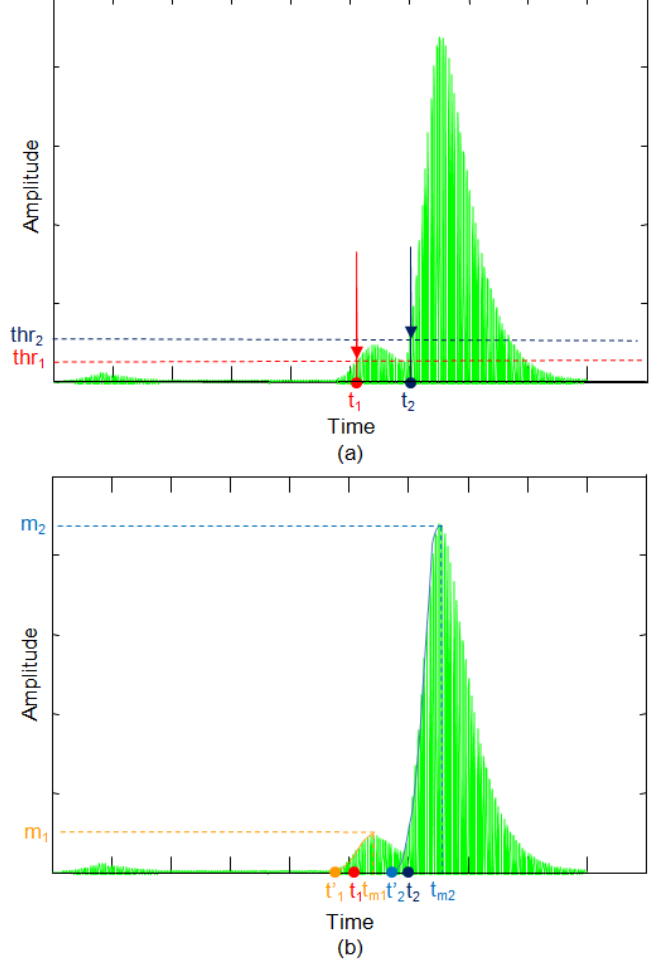
Figure 20. Comparison of methods: ( a ) threshold; ( b )